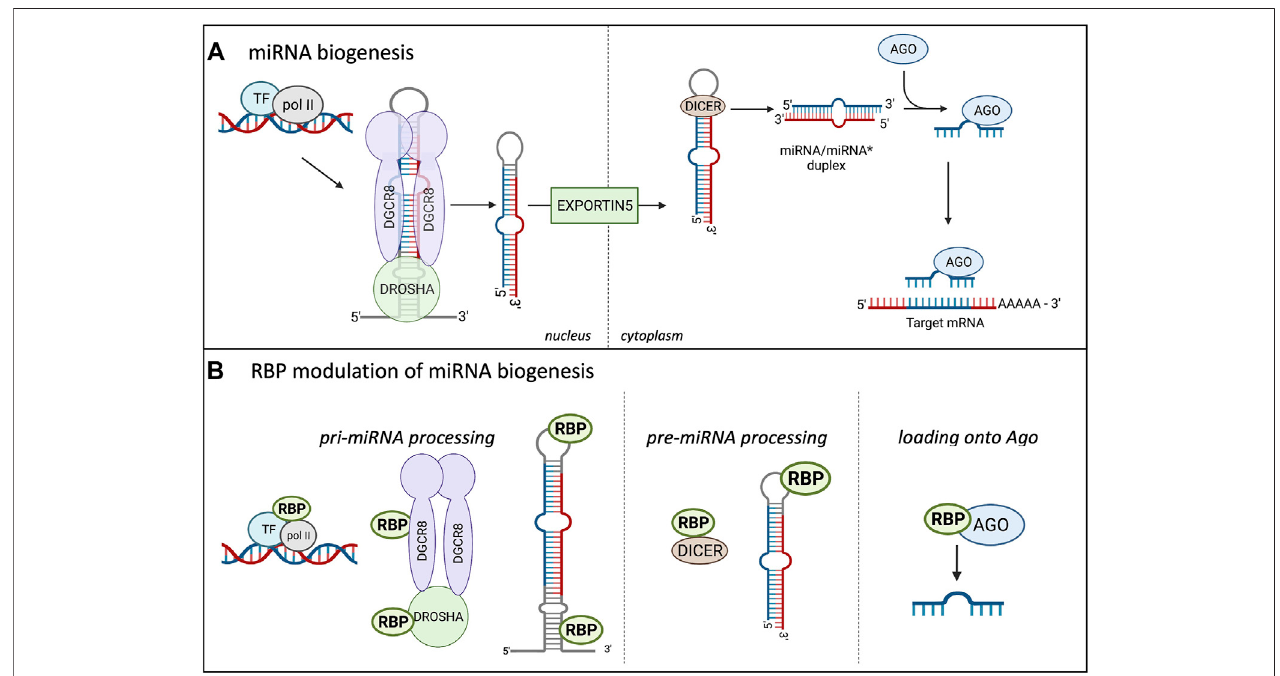
FIGURE 1 | Canonical miRNA biogenesis in Eukaryotes and the in fl uence of RBPs. (A) shows the miRNA biogenesis in eukaryotes. miRNAs are transcribed in the nucleus by RNA polymerase II (pol II), creating the pri-miRNA, two sequential cleavage reactions follow. The microprocessor consists of Drosha and DGCR8 and performs the fi rst cleavage reaction in the nucleus, creating the pre-miRNA. The pre-miRNA is transported into the cytoplasm through Exportin5 where the second cleavage reaction occurs. Dicer cleaves the terminal loop of the pre-miRNA, creating the miRNA/miRNA* duplex. The miRNAs are incorporated into the Ago protein, forming the minimal effector RNA induced silencing complex (miRISC) and target mRNA sequences. (B) Highlights the modulation of miRNA biogenesis by RBPs. RBPs can bind to the promoter region of certain miRNAs and in fl uence their transcription. RBPs modulate miRNA expression at the pri-miRNA processing level throughbinding toDroshaand enhance orrepress thecleavage. RBPscanalso bindtotheterminallooporothersequencesinthepri- and pre-miRNAs toin fl uencethe cleavage reactions. Additionally, RBPs can bind to DICER and in fl uence this cleavage reaction through modulating DICER expression and availability. Lastly, RBPs can bind to AGO and increase the miRNA loading onto the AGO, increasing the miRISC